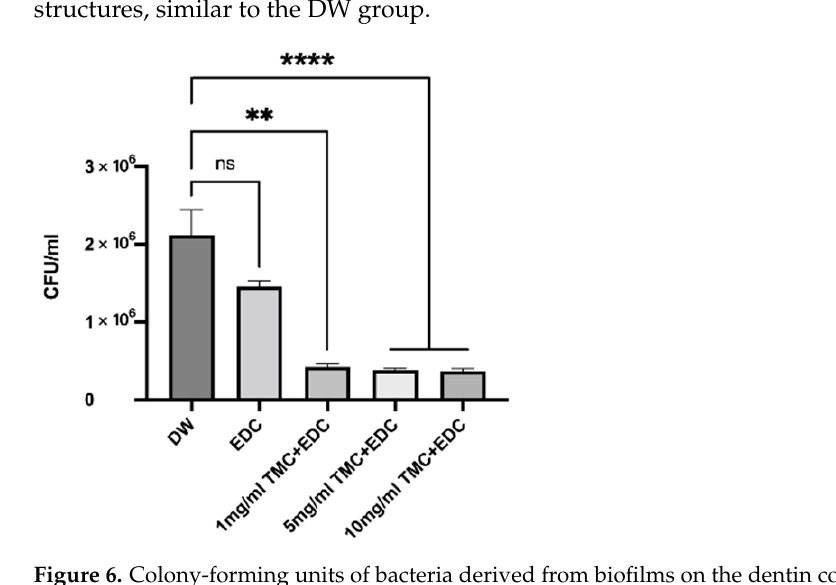
Figure 7. Representative CLSM images of E. faecalis biofilms in dentin tubules of different treat- ments, ( A ): DW; ( B ): EDC; ( C ): 1 mg/mL TMC + EDC; ( D ): 5 mg/mL TMC + EDC; ( E ): 10 mg/mL TMC + EDC.